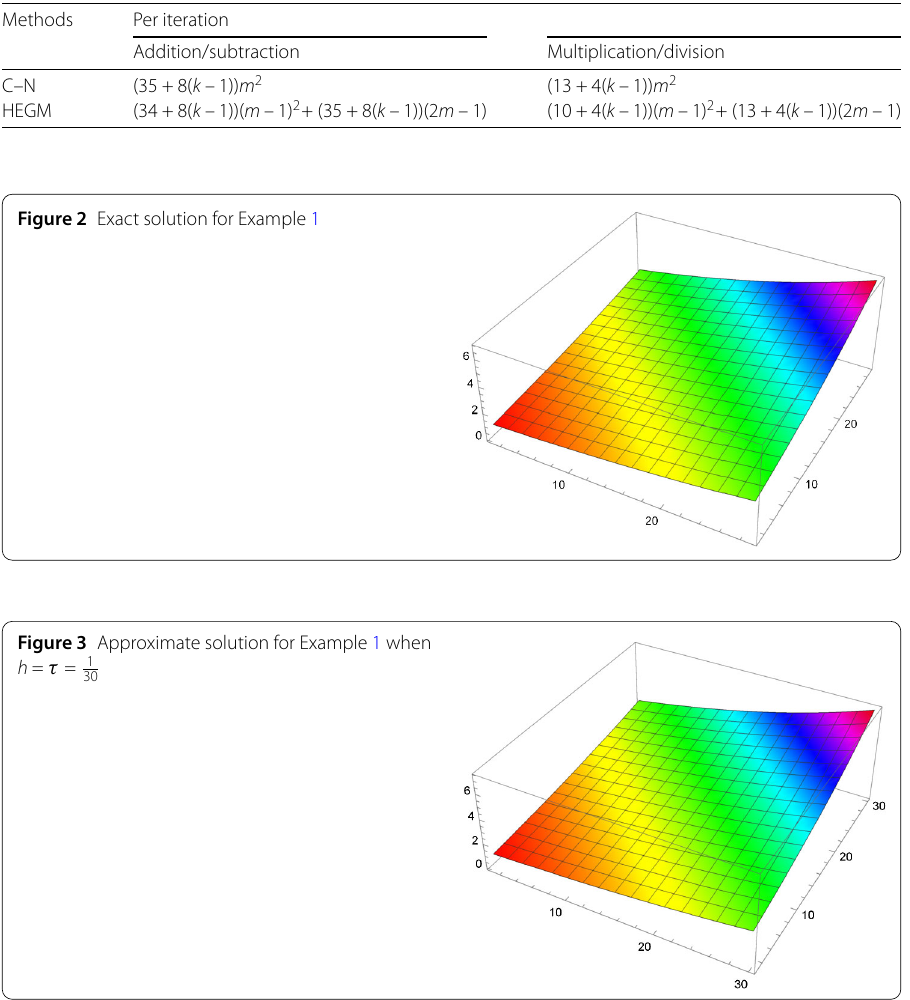
Table 15 Computational complexity for the HEGM and C–N high-order finite difference method